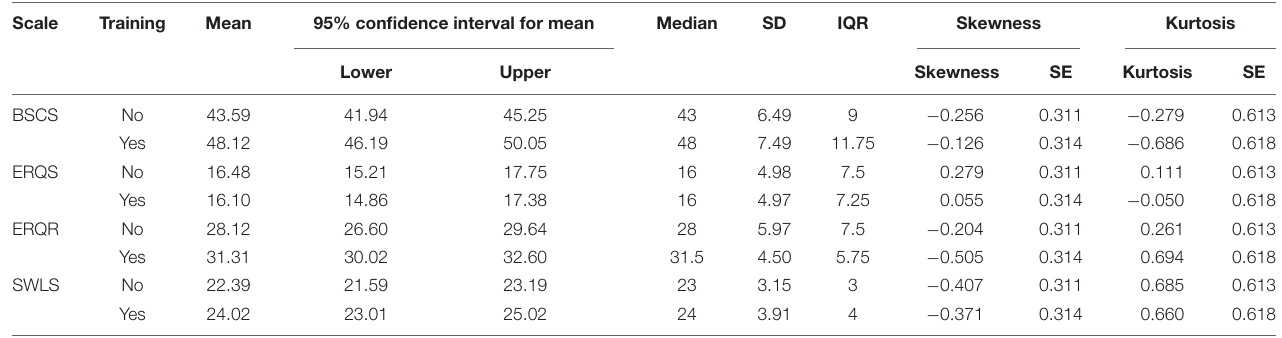
TABLE 1 | Descriptive statistics for scores on scales of self-report